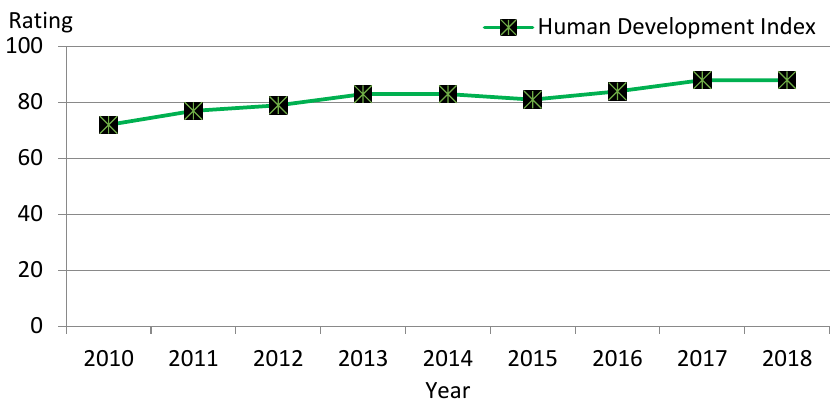
Fig. 5: The Human Development Index of Ukraine (HDII,